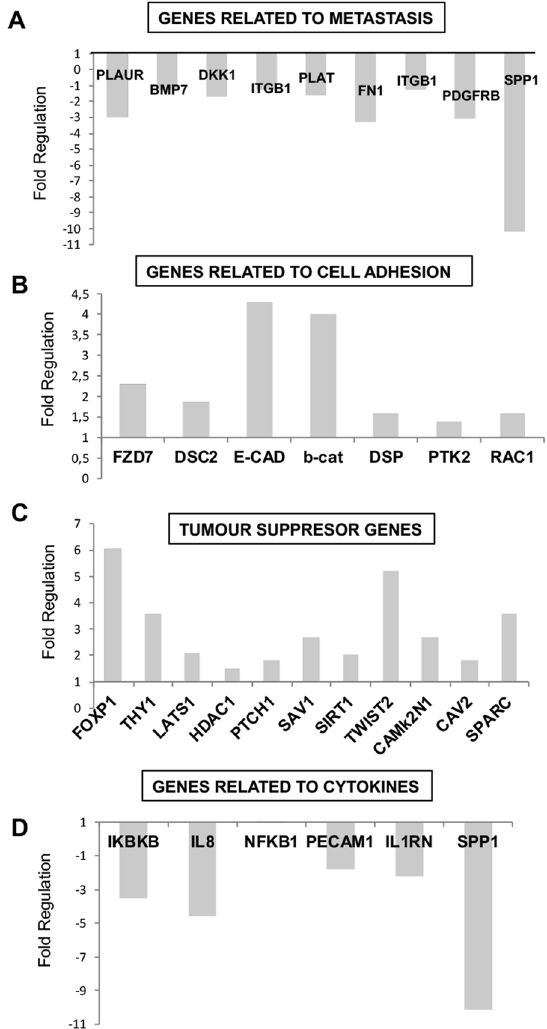
Figure 3. Human EMT and CSCs RT2 Profiler PCR Array of BxPC3 CSCs treated with PRP. BxPC3 CSCs were treated with PRP on day 2 and on day 4. On day 5, total RNA from treated and non-treated CSCs was extracted. A pool of three total RNAs extracted from three independent experiments was used for first strand cDNA synthesis. Gene expression was determined using RT 2 Profiler PCR Array of EMT and CSCs. ( A ) Expression of genes genes related to metastasis. ( B ) Expression of genes related to cell adhesion. ( C ) Expression of tumour suppresor genes. ( D ) Expression of genes related to cytokines. All gene expressions were normalised to the untreated